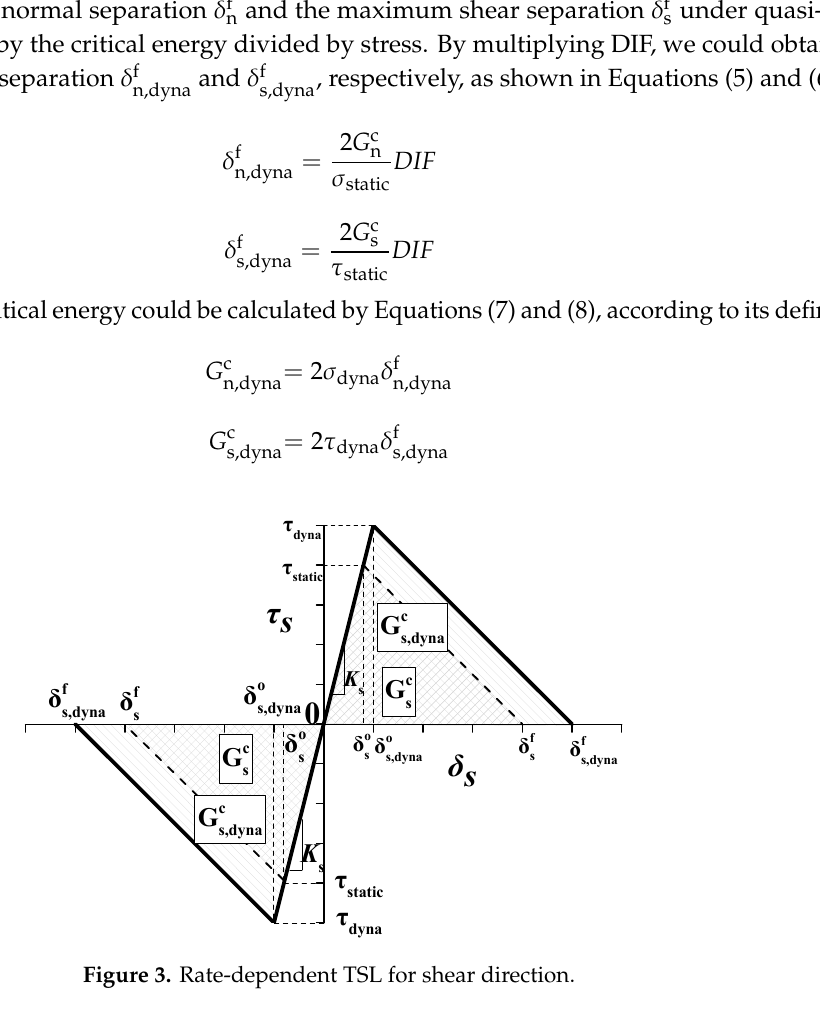
Figure 2. Rate-dependent traction–separation law in normal direction.